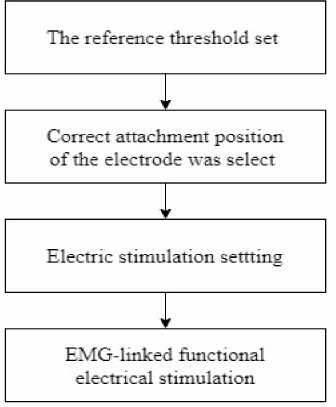
Figure 1. Diagram of EMG-FES